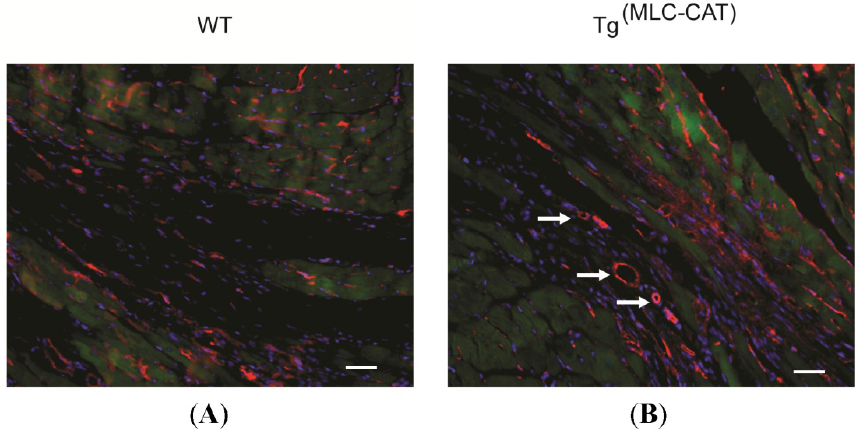
Figure 6. Increase in endothelial cells and vessels in Tg (MLC − CAT) mice. ( A , B ) Representative images of infarct tissue stained with isolectin for endothelial cells (red = isolectin; green = autofluorescence; blue = DAPI). White arrows point to vessels, scale bars = 50 µm; ( C ) Quantitative assessment of numbers of vessels and ( D ) endothelial cells, were increased in Tg (MLC − CAT) mice as compared to WT mice at 21 days following myocardial infarction. Values are mean ± SEM; n = 4 per group; * p < 0.05, ** p < 0.01 t